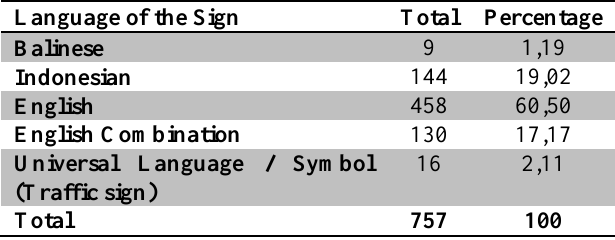
Tab. 2: Language Use in Outdoor Signs in Ubud